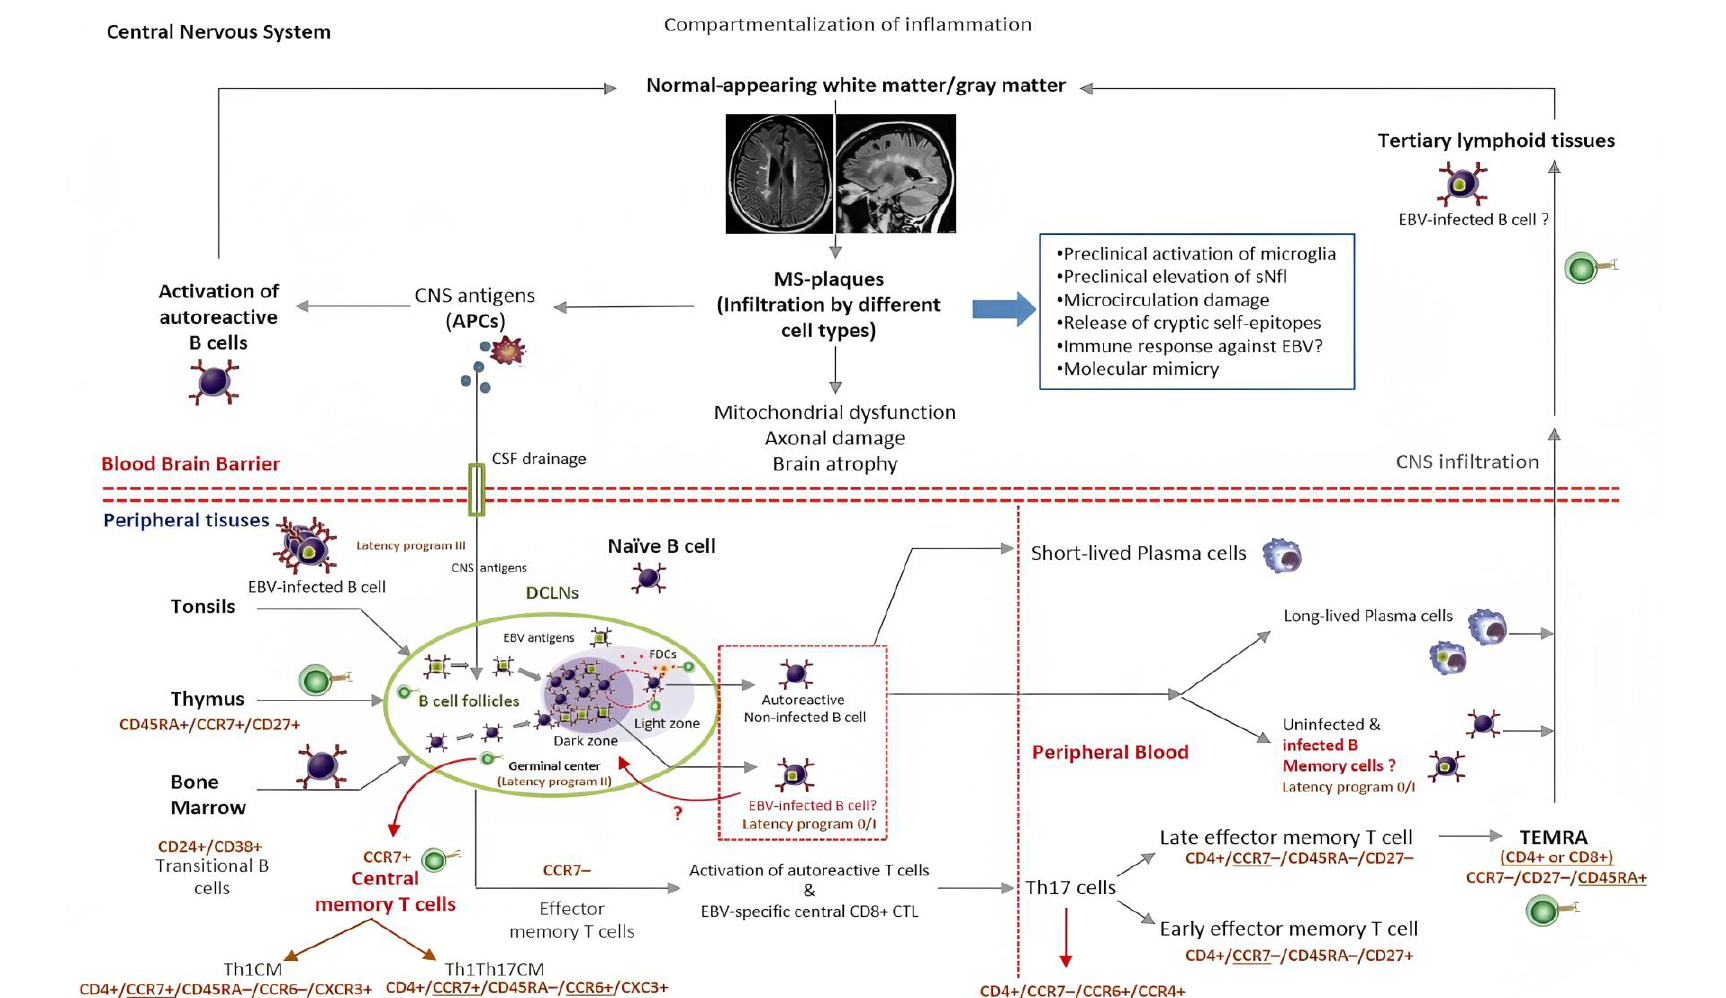
Figure 3. Theoretical model for the role of EBV in the pathogenesis of MS (simplified view). EBV may act as the main trigger of the inflammatory cascade that starts demyelination in the CNS of susceptible individuals. In the upper half, the activation of autoreactive B cells, the continuous drainage of CNS-antigens, the